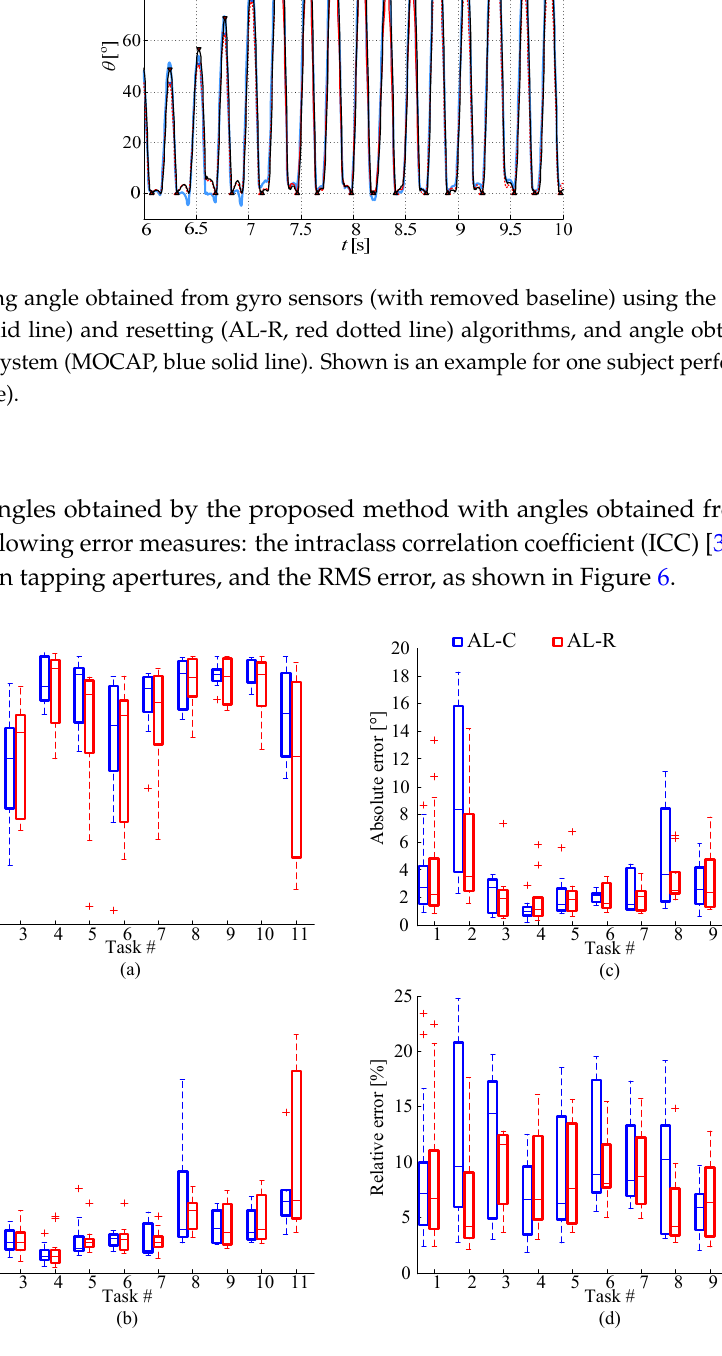
Figure 6. Boxplots comparing tapping angles obtained from gyro sensors and cameras in terms of: ( a ) Intraclass correlation coefficient (ICC); ( b ) RMS error between angles; ( c ) absolute error for tapping aperture; and ( d ) relative error for tapping aperture. Results are presented for all subjects, grouped according to eleven tapping tasks from Table 1, showing average values and standard deviations, for continuous and resetting algorithms.